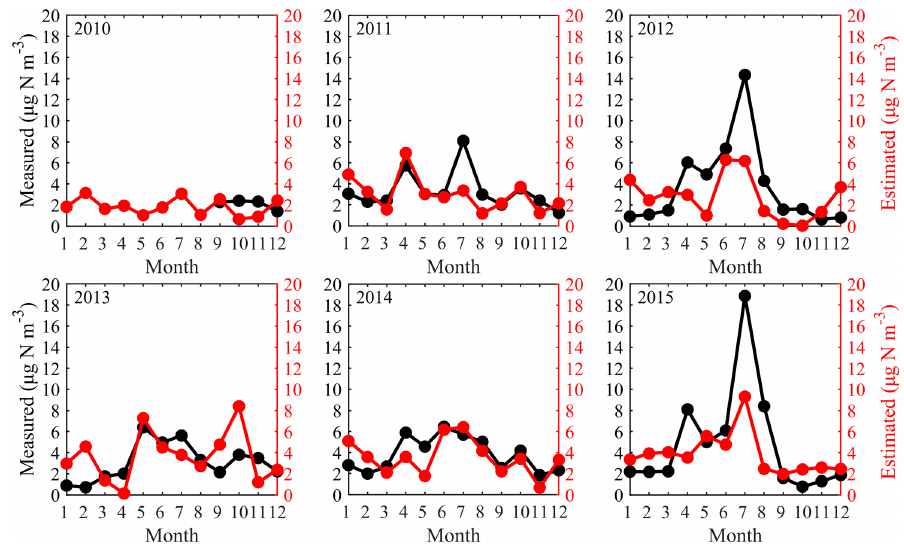
Figure 6. Monthly changes in NH 3 concentrations in Huinong County in Ningxia from 2010 to 2015 for a total of 72 months during